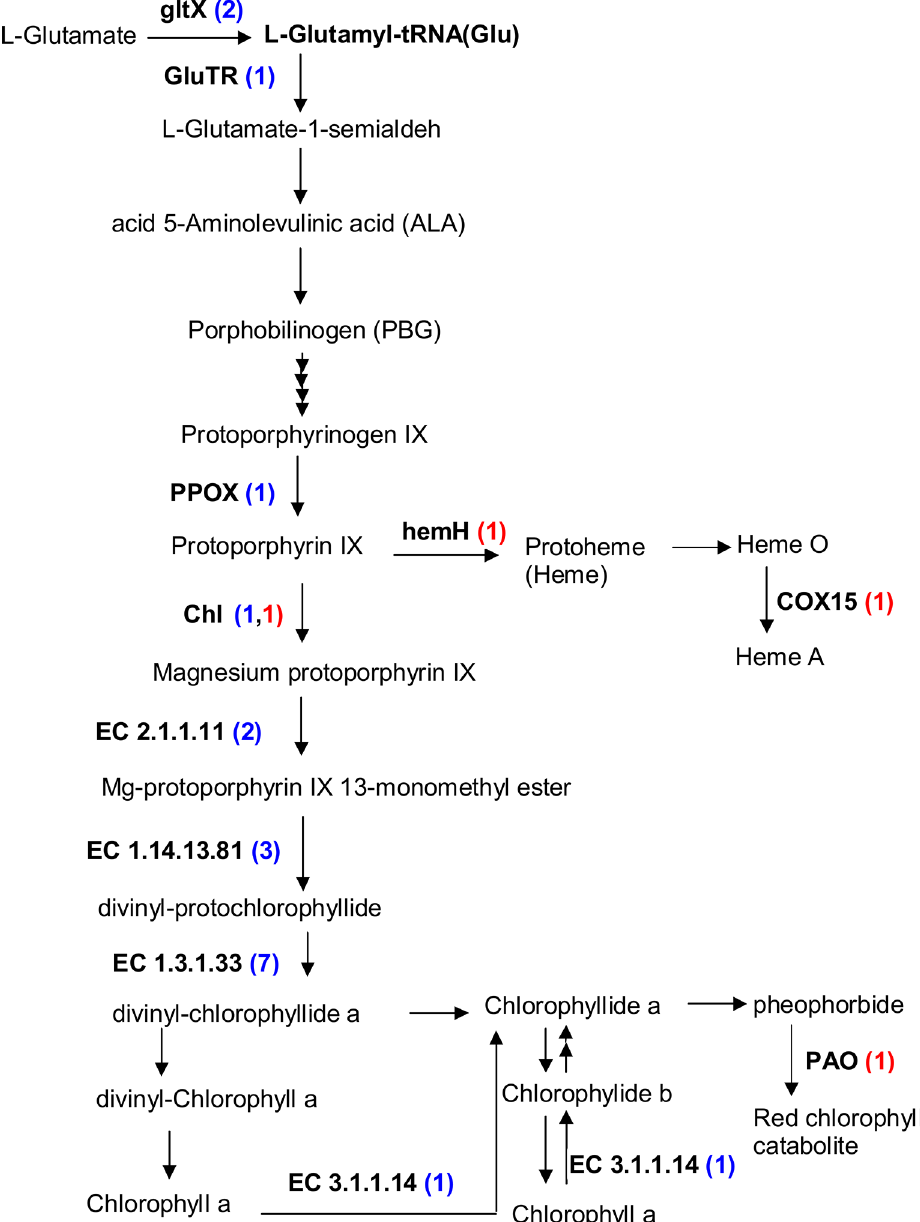
Fig 8. Chlorophyll metabolism in ‘ Meyer ’ under cold stress. gltX, glutamyl-tRNA synthetase; GluTR, Glutamyl-tRNA reductase; PPOX, protoporphyrinogen oxidase; Chl H, magnesium chelatase; EC 2.1.1.11, magnesium protoporphyrin IX methyltransferase; EC 1.14.13.81, magnesium-protoporphyrin IX monomethy lester (oxidative) cyclase; EC 1.3.1.33, protochlorophyllide reductase; EC 3.1.1.14, chlorophyllase; PAO, Pheophorbide a oxygenase; Hem H, ferrochelatase; COX15, cytochrome c oxidase 15 (Heme A synthase). In brackets, red numbers represent the number of up-regulated unigenes, blue numbers represent the number of down-regulated